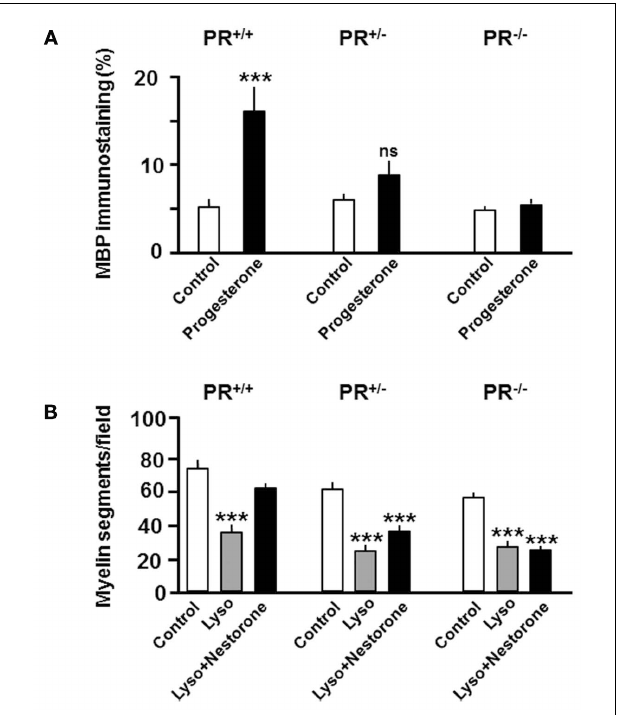
FIGURE 4 | Intracellular progesterone receptors are key limiting factors in progesterone-driven myelin formation. (A) Role of progesterone receptors (PR) in developmental myelination. PR is necessary for the stimulation of myelin basic protein (MBP) expression by progesterone, analyzed by quantifying MBP immunostaining in organotypic cultures of cerebellar slices taken from postnatal day 7 mice and cultured for 7days in the absence (control) or presence of progesterone (20 μ M). (B) PR is also necessary for the stimulation of myelin repair by the selective progestin Nestorone (20 μ M). Cerebellar slices from postnatal day 10 mice were cultured for 7days to allow extensive myelination of axons.The slices were then demyelinated by treating them overnight with lysolecithin, and they were cultured for an additional 4days in the absence (Lyso) or presence